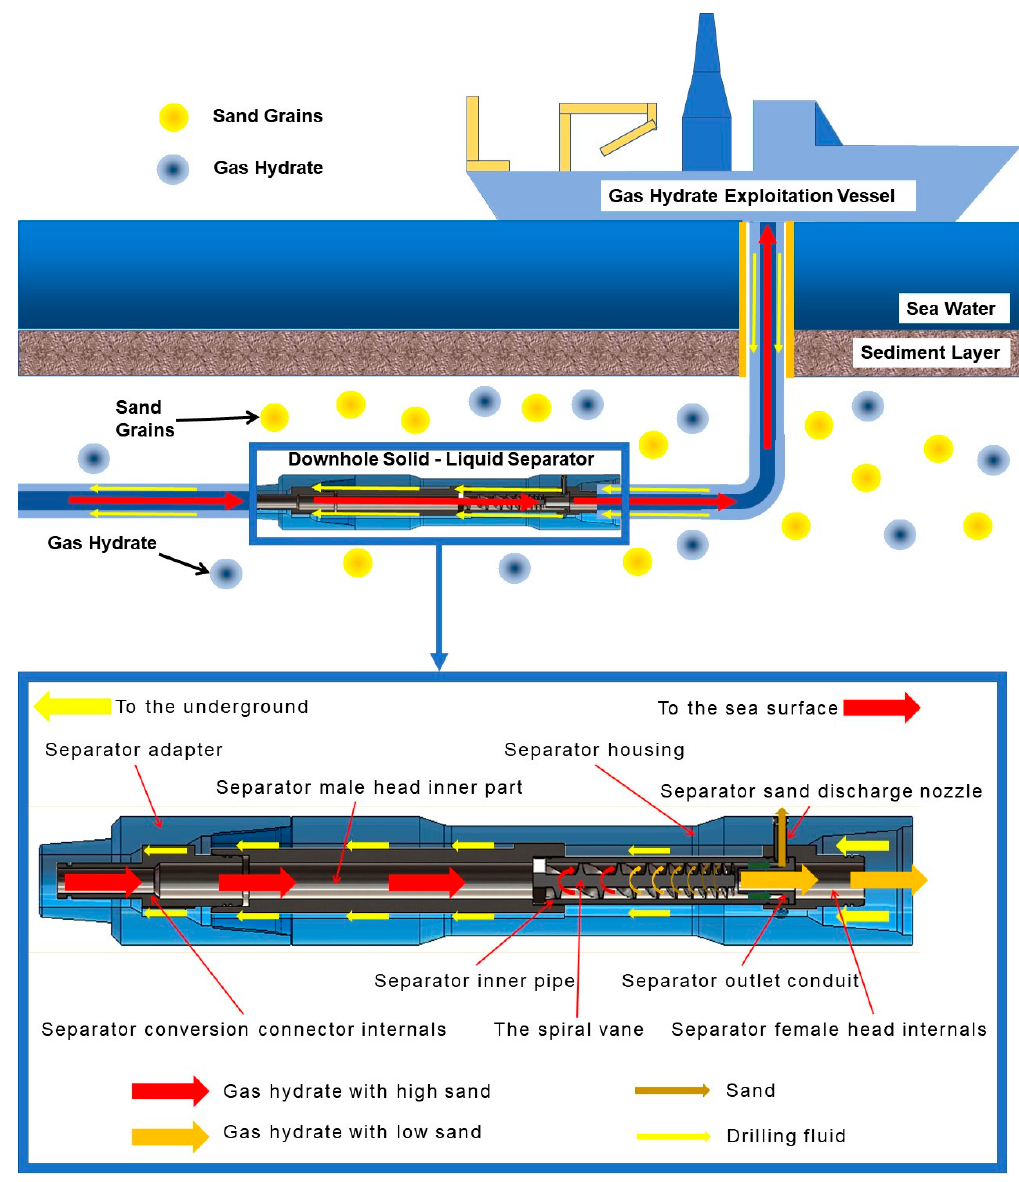
Figure 1. Application scenario of downhole solid–liquid separator.